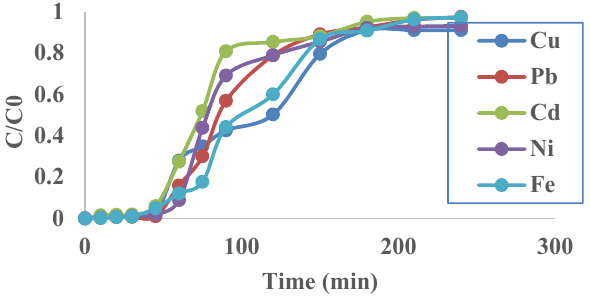
Figure 6. The breakthrough curve for the adsorption of simulated wastewater contaminated with Cu, Fe, Cd, Ni and Pb (flow rate of the solution is 6 ml/min; bed depth 2 cm).